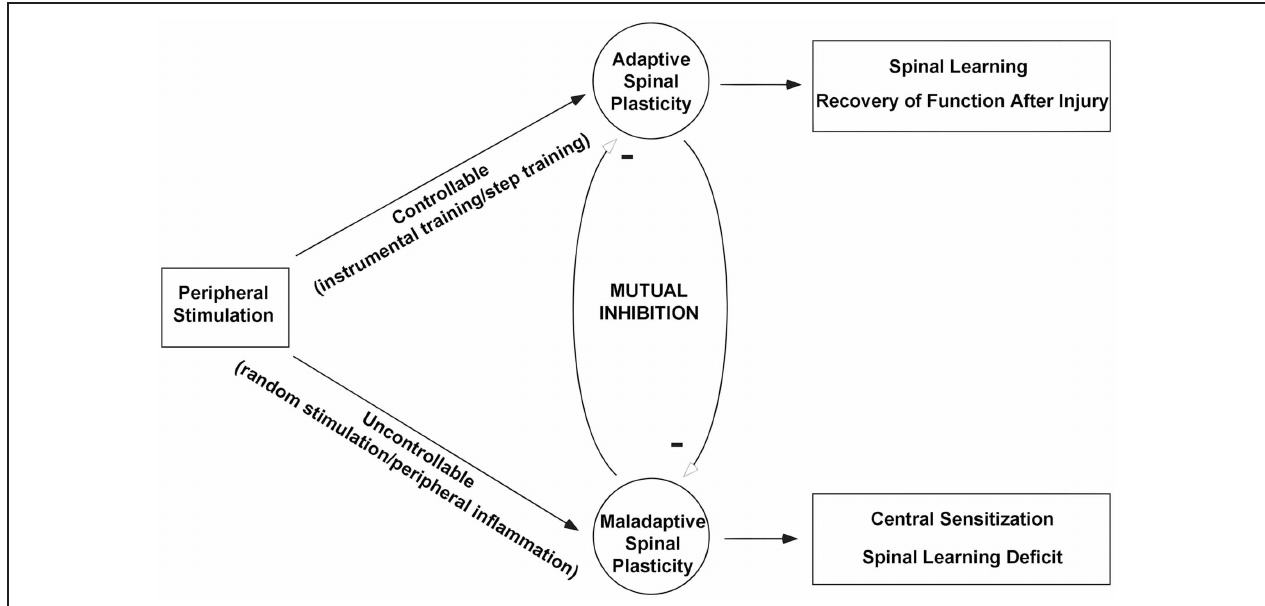
FIGURE 8 | Theoretical framework for understanding the relationship between adaptive and maladaptive spinal cord plasticity. After spinal cord injury peripheral stimulation can take a controllable form such as instrumental training or step training that promotes adaptive plasticity and leads to further improvements in spinal learning and recovery of function. On